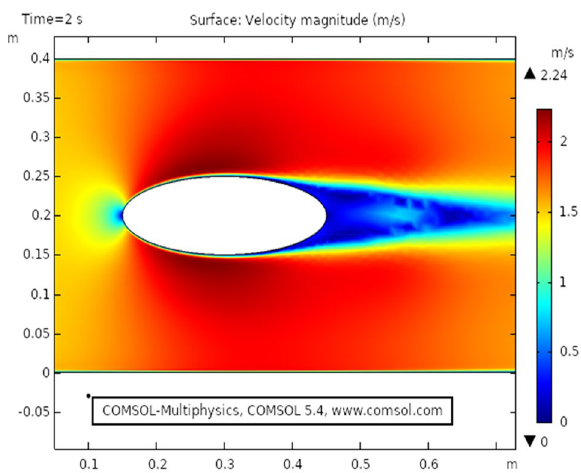
Figure 5. The velocity distribution in cylindrical elliptic flow at t = 2 s